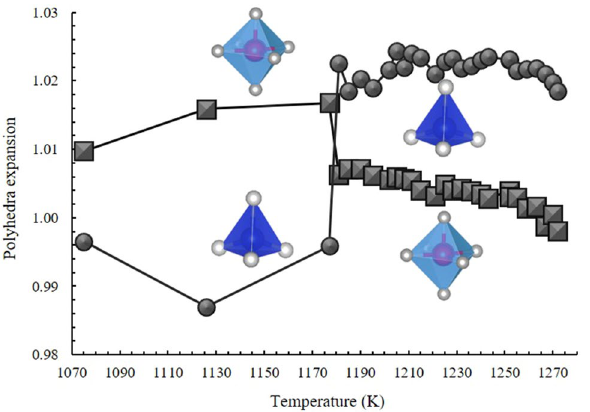
Figure 8. Polyhedral evolution of topaz in the critical zone (1071–1273 K) expressed as V / V 0 as obtained from neutron data. The octahedral expansion (square symbols) is continuously balanced by a tetrahedral contraction (circle symbol) up to 1170 K, where a strong F loss, accompanied by a crystallinity loss and a phase change are envisaged. At higher temperature the concomitant expansion and contraction of tetrahedra and octahedra, respectively, is minimized. For sake of clarity octahedra (light blue) and tetrahedra (dark blue) are also represented.